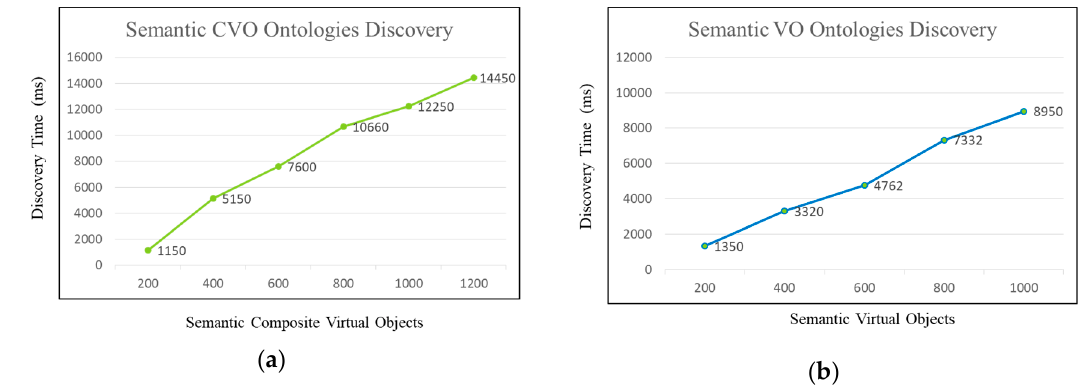
Figure 25 ( a ) CVOs semantic ontologies discovery, ( b ) VOs semantic ontologies discovery. Figure 25. ( a ) CVOs semantic ontologies discovery, ( b ) VOs semantic ontologies